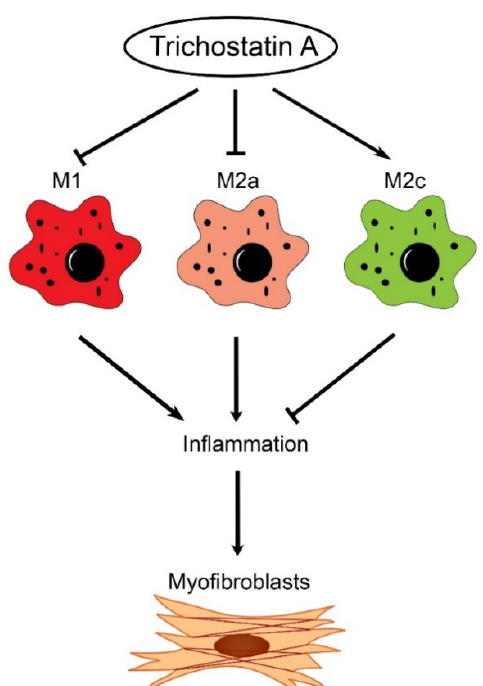
Figure 7. Proposed immunomodulatory and antifibrotic mechanism by trichostatin A in renal fibrosis. In a mice model of unilateral ureteral obstruction, the administration of trichostatin A suppresses the infiltration of proinflammatory M1a and M2a macrophages, as well as promotes the accumulation of anti-inflammatory M2c macrophages, thereby limiting excessive inflammation. Accordingly, the activation of myofibroblasts is limited, and renal fibrosis is attenuated.